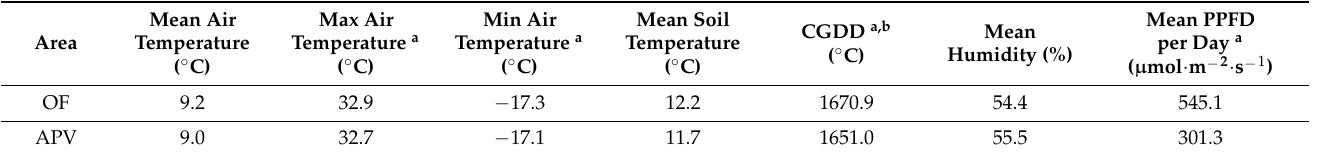
Table 1. Microclimate information under open-field and agriphotovoltaic